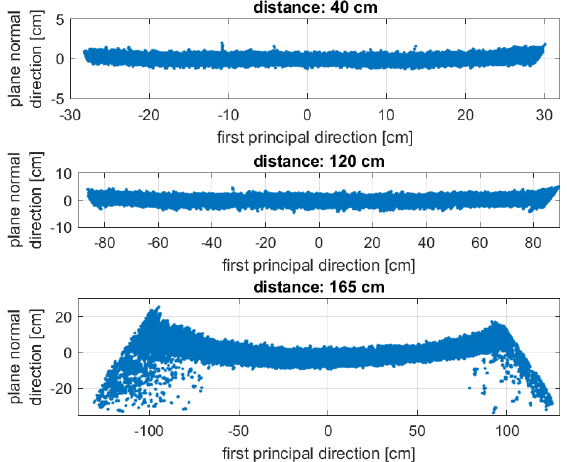
Figure 9. Fitting errors of PicoZense DCAM710 point